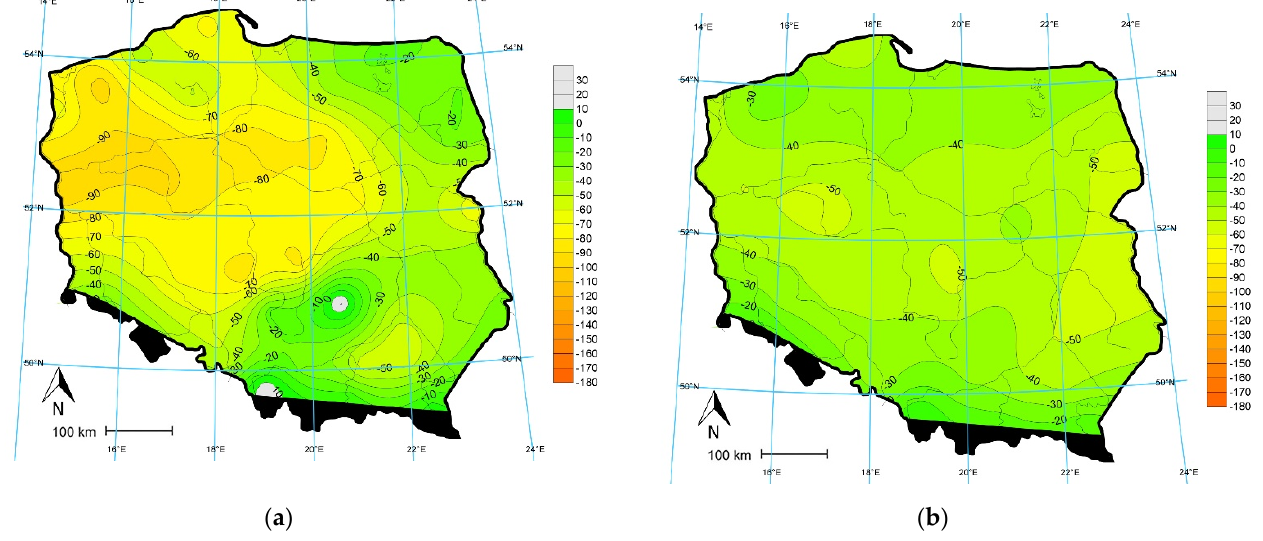
Figure 6. Climatic water balance (CWB) in August: ( a ) 2019; ( b ) 1981–2010. Explanation same as in Figure 2. In light of the comparison presented, June saw with the highest temperature deviation from normal and low rainfall, and was the month with the highest CWB deviation of 50 mm. The values of these deviations from normal decreased to − 28 mm in July and − 15 mm in August (Table 1).